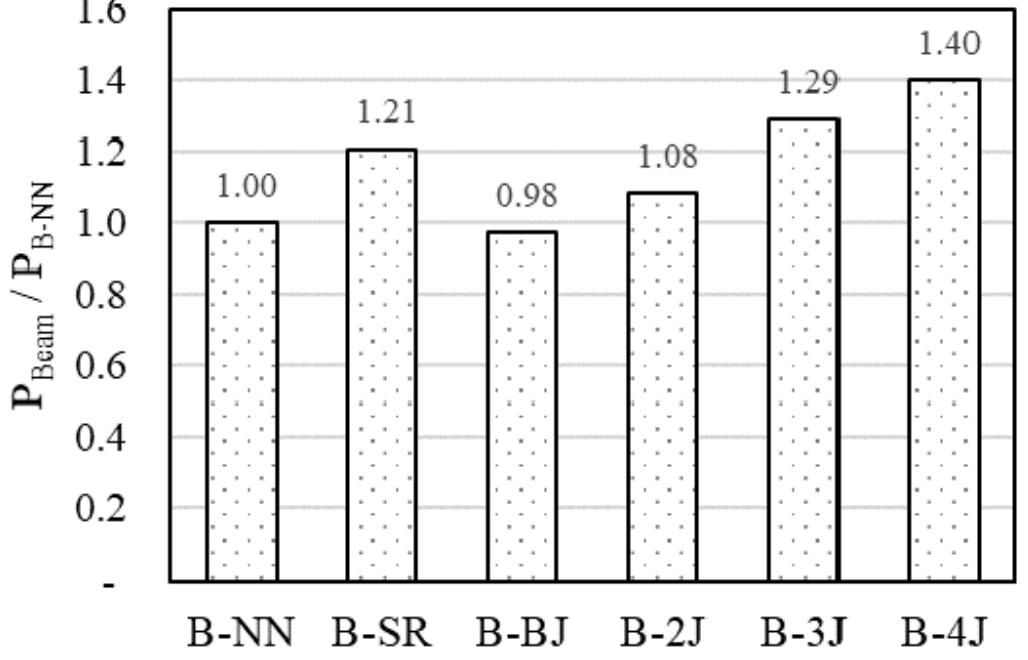
Figure 12. E ff ect of strengthening method on peak load of test Figure 12. Effect of strengthening method on peak load of test beam.